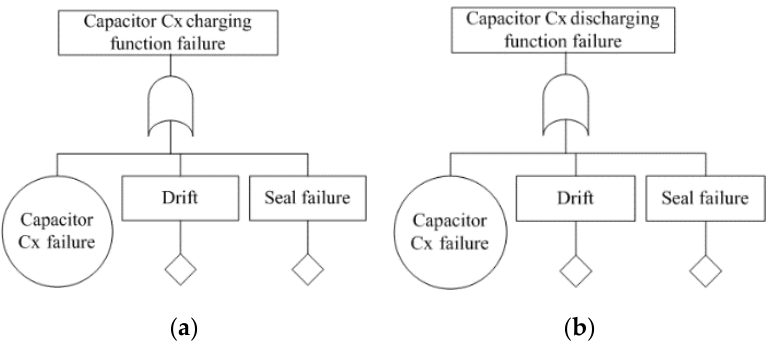
Figure 17. Sub fault tree for capacitor function failure: ( a ) charging, ( b ) discharging.